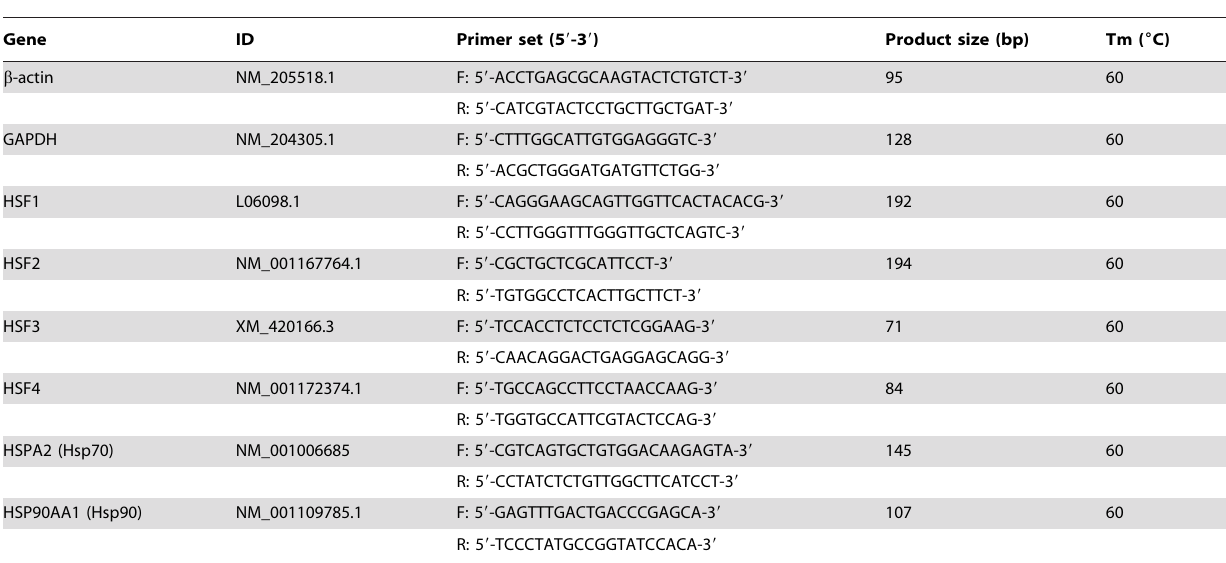
Table 2. Information of target genes and primers.